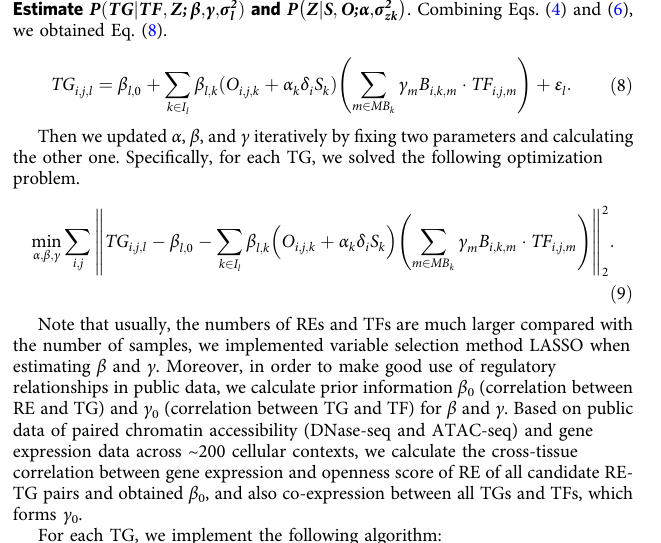
to reveal the speci fi c DNA sequence information of our hypoxia induction experiment. Δ DAF is de fi ned as the derived allele frequency of 5 Tibetans minus the derived allele frequency of 5 Hans.